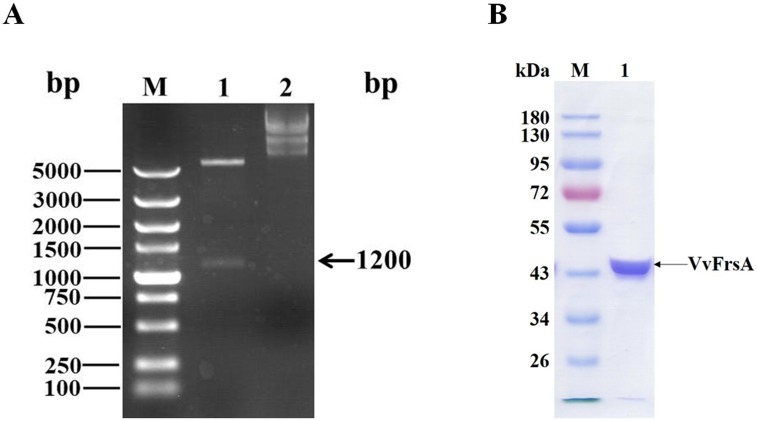
Construction of expression plasmid and purification of VvFrsA.A. Agarose gel of pET28a-VvFrsA plasmid. M: DNA marker; 1: pET28a-VvFrsA plasmid after digestion with NdeI and XhoI; 2: plasmid of pET28a-VvFrsA. B. SDS-PAGE gel of purified VvFrsA. M: protein marker; 1: purified VvFrsA.